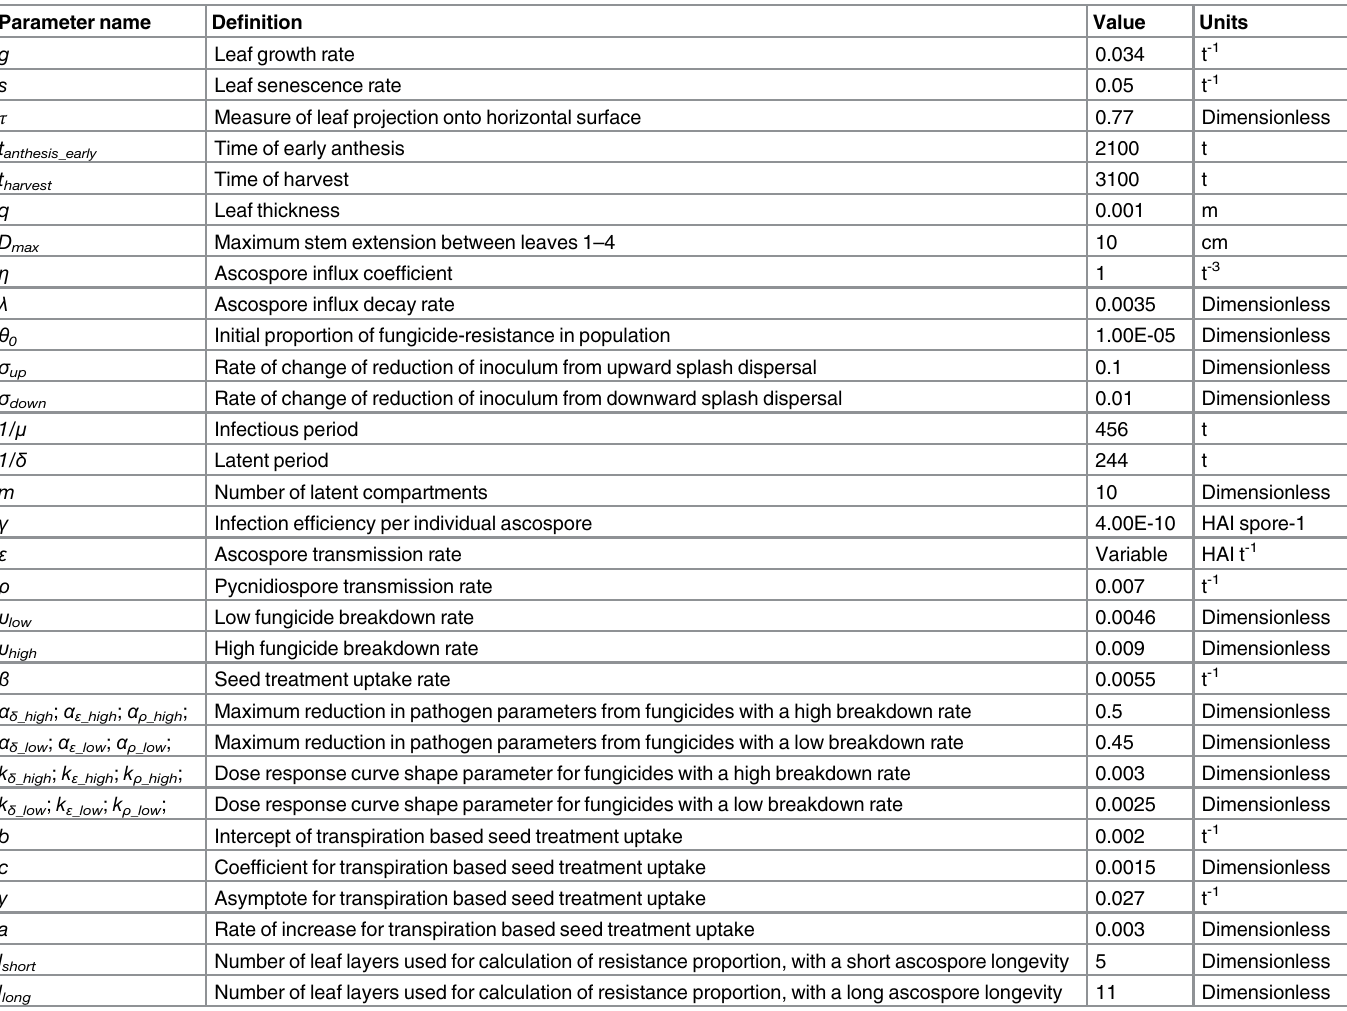
Table 1. Parameter symbols, descriptions, values and